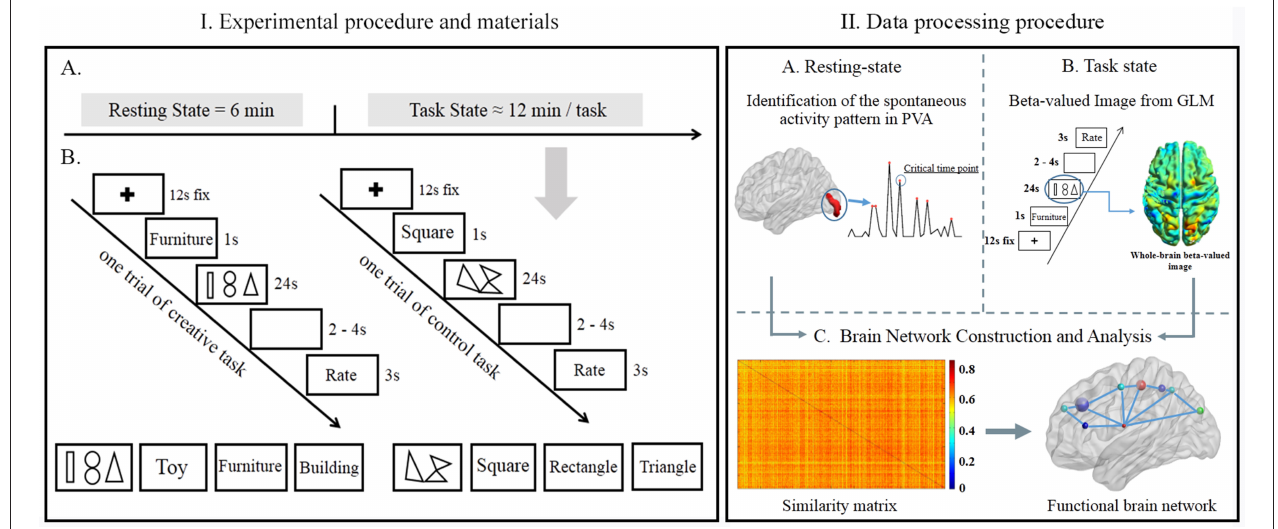
FIGURE 1 | (I) Experimental procedure and materials. (A) General experimental procedures in detail; (B) samples of experimental categories and materials in the visual creative synthesis task (left) and control task (right). (II) Data processing procedure. From (A to C) represent the resting-state fMRI (R-fMRI) data processing procedure; from (B to C) demonstrate the Task-fMRI (T-fMRI) data processing procedure. PVA, primary visual area; GLM, general linear